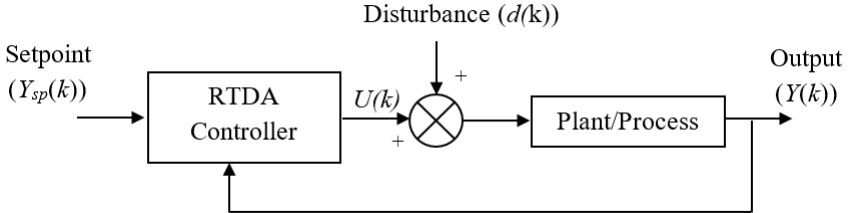
Figure 1. General closed loop diagram with a robust, tracking, disturbance rejection and aggressiveness (RTD-A) controller.